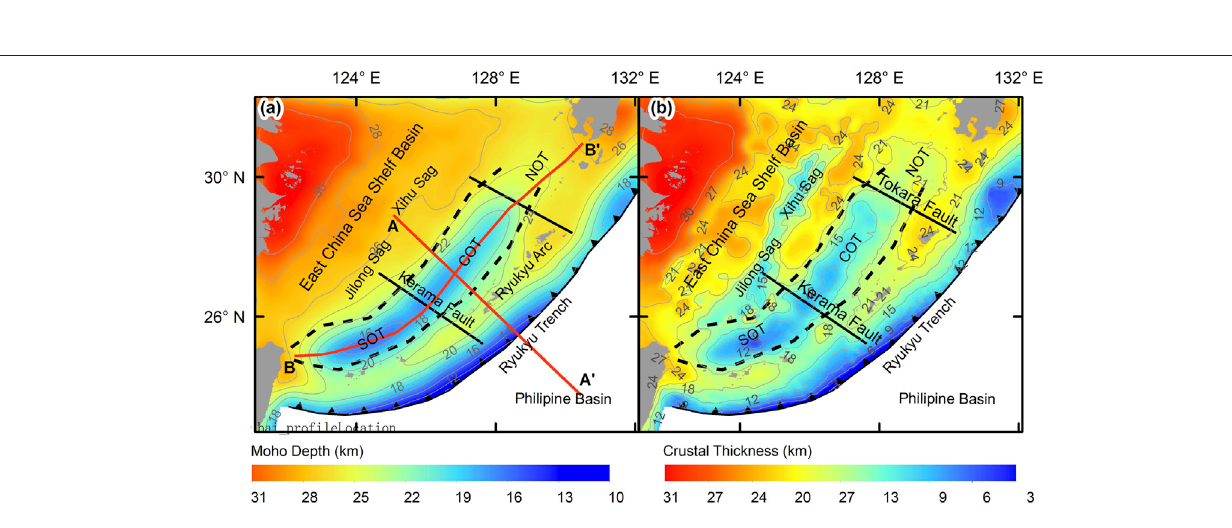
Frontiers in Earth Science |